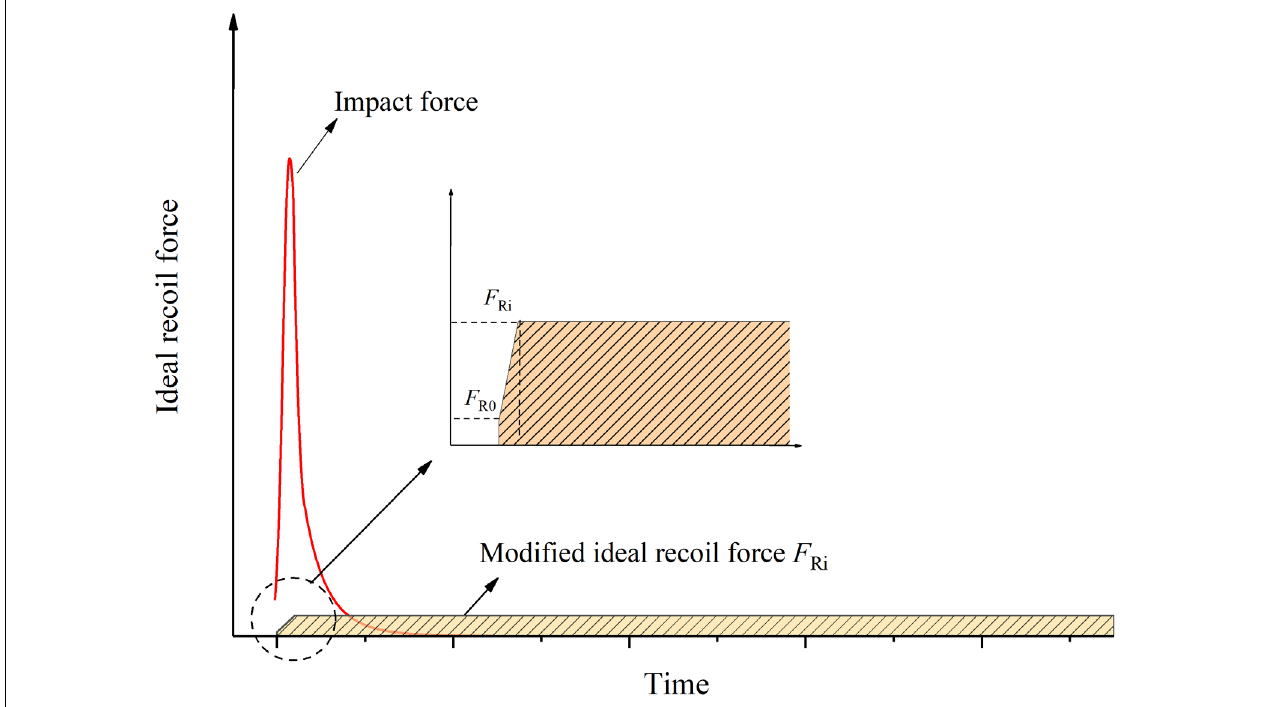
FIGURE 2 | Modified recoil force in actual recoil